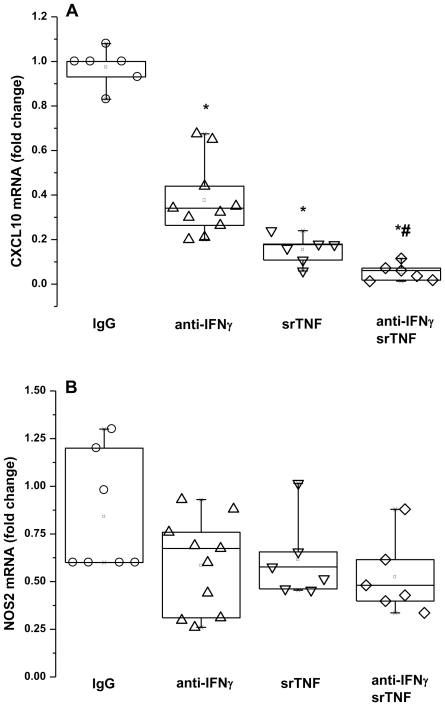
Anti-IFNγ and TNF soluble receptor p75 strongly reduce epithelial CXCL10 mRNA expression but only partially attenuate epithelial NOS2 expression induced by T cells.HNEC were co-cultured with activated T cells in the absence or presence of anti-IFNγ, TNF soluble receptor (srTNF) or an isotype-matched antibody (IgG). CXCL10 (A) and NOS2 (B) mRNA were measured by real-time PCR. Data are presented as fold change relative to those obtained in the absence of neutralizing agents. Shown are the boxplots with the 25th, 50th (median), 75th percentiles, the mean (open square), the maximum and the minimum values. *p<0.05 compared with isotype matched IgG treated cultures. #p<0.05 compared with anti-IFNγ and srTNF treated cultures.